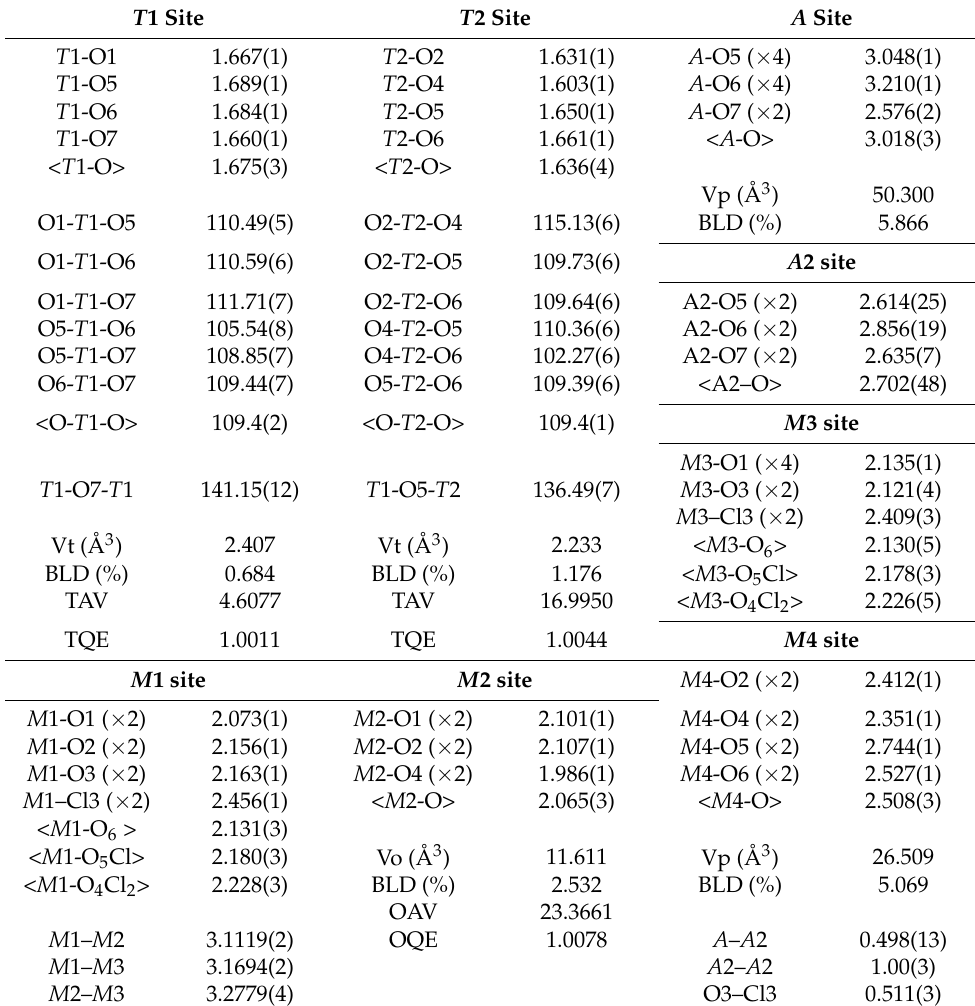
Table 7. Selected bond distances (Å), angles and calculated geometrical and distortion parameters for tatrahedra, octahedra and polyhedra in the crystal structure of the studied potassic-hastingsite sample. The volume of the coordination tatrahedra, octahedra and polyhedra (Vt, Vo and Vp), as well as bond length distortion (BLD), tetrahedral and octahedral angle variance (TAV and OAV) and tetrahedral and octahedral quadratic elongation (TQE and OQE) were calculated using VESTA (version 4.3.0) [39] according